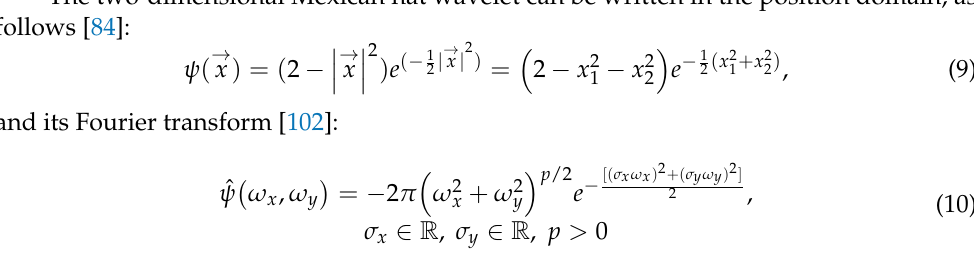
Figure 10. Graphs of the most common wavelets used for continuous analysis: ( a ) Morlet, ( b ) a Gaussian derivative, and ( c ) a Mexican hat.